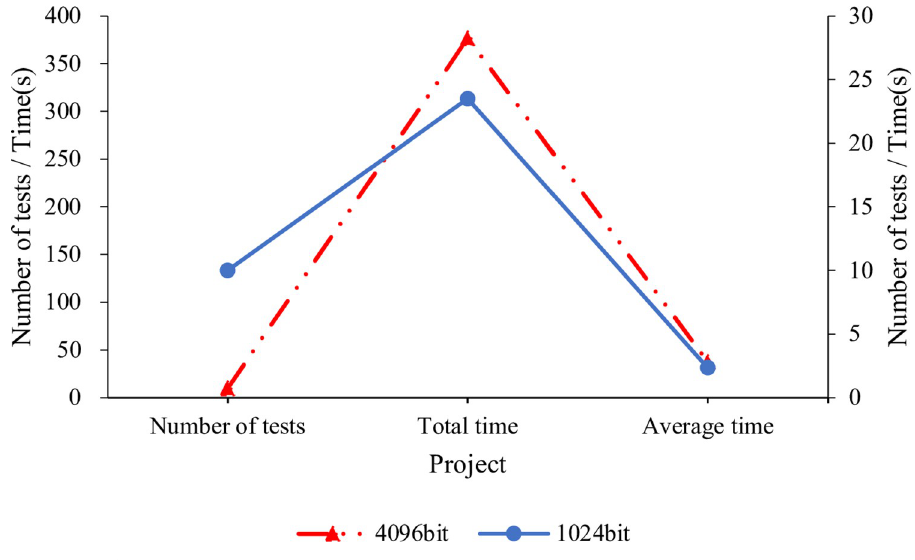
Fig 10. RSA key generation